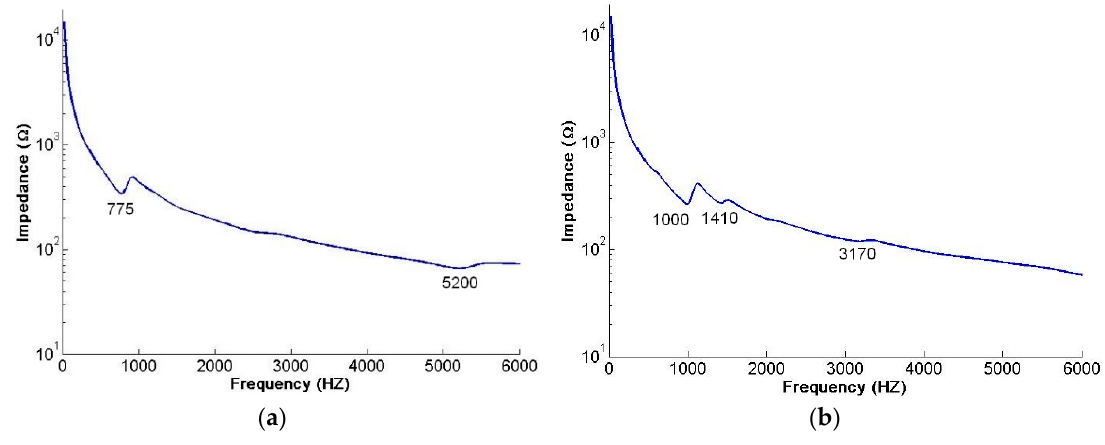
Figure 16. Impedance variation curve of glycerine-coupled ( a ) anti-phase vibration and ( b ) in-phase